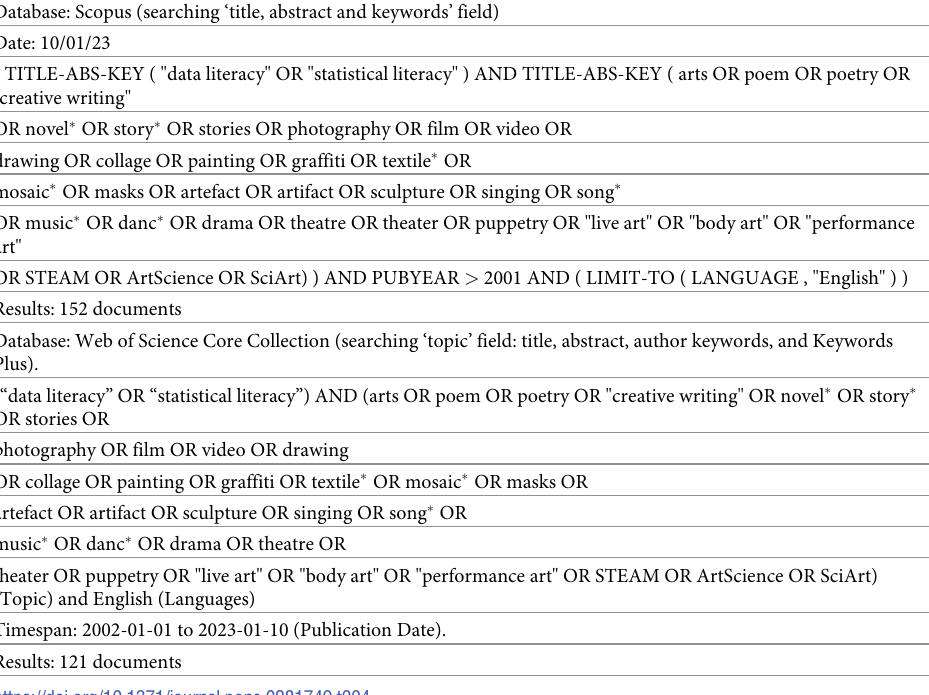
Table 4. Examples of preliminary database